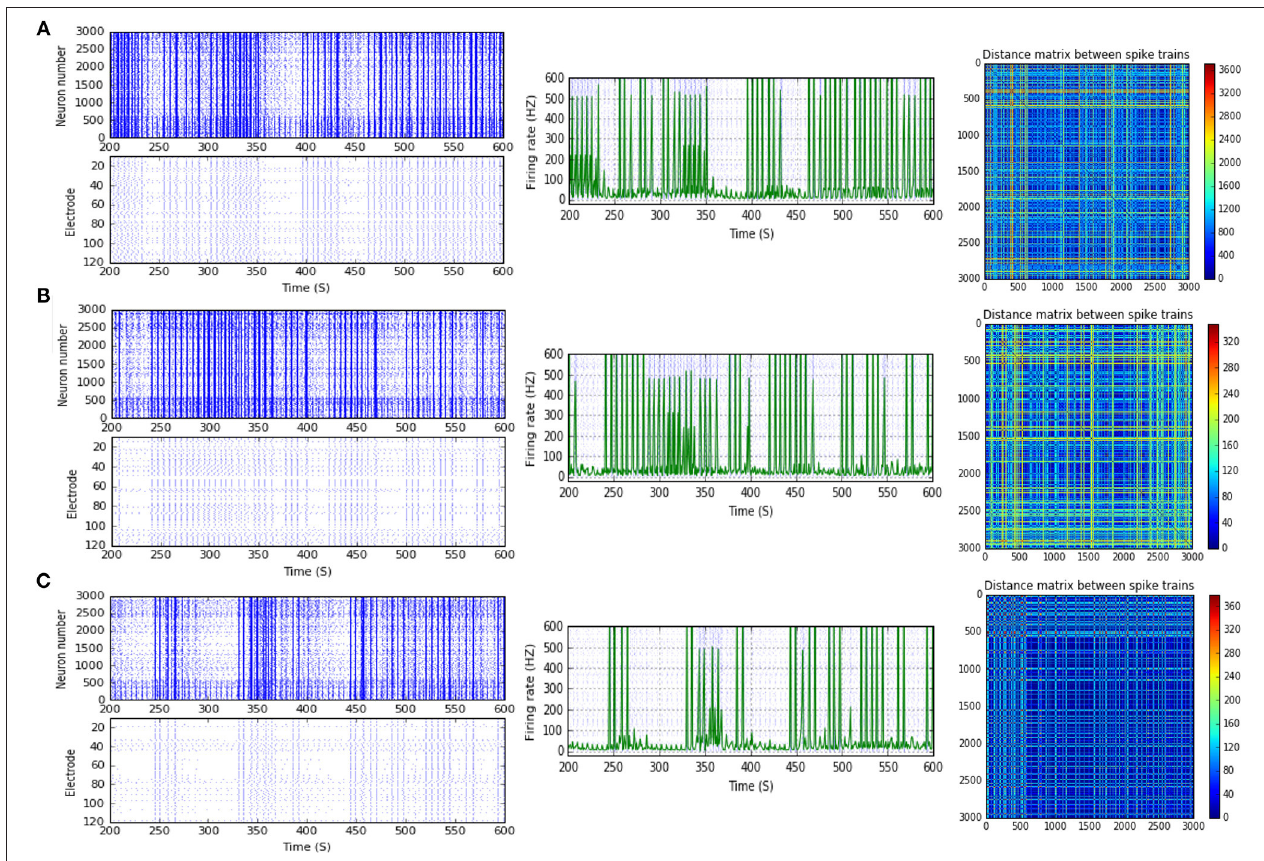
FIGURE 10 | Selected elicited firing response activity in the immature network scenario (B-2) before and after implementing STF1 and STF2 (when IF range of low gamma). (A) refers to the condition without implementing dynamical synapses (control) while (B,C) refer to that after implementing facilitating synapses (STF1 and STF2, respectively). The first two figures of each panel refer to monitoring the pattern of firing activity in time windows from 200 to 600 seconds(s). Heat maps of each panel represent modulation changes in spike distance matrix of the network scenario (B-2) before and after implementing STF1 and STF2. The simulation time for heat maps of the spike distance is equal to